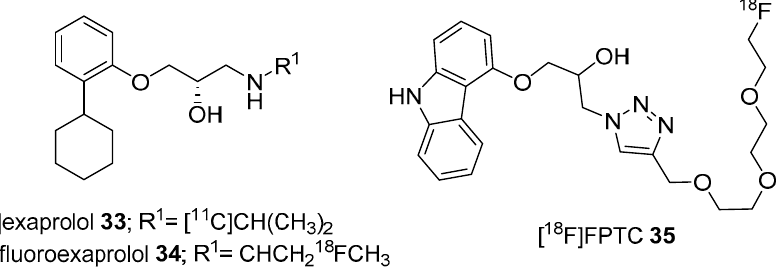
Figure 10. Another set of latest β -AR PET radiotracers.